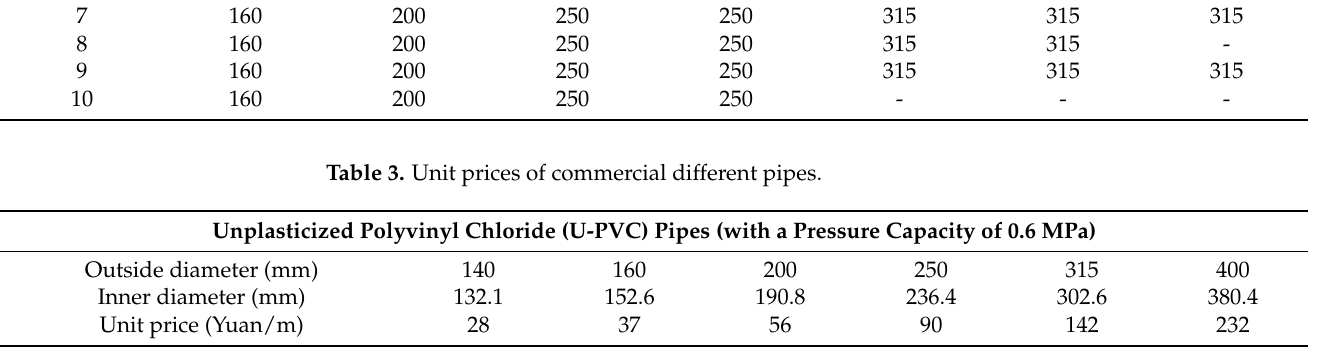
Table 3. Unit prices of commercial different pipes.